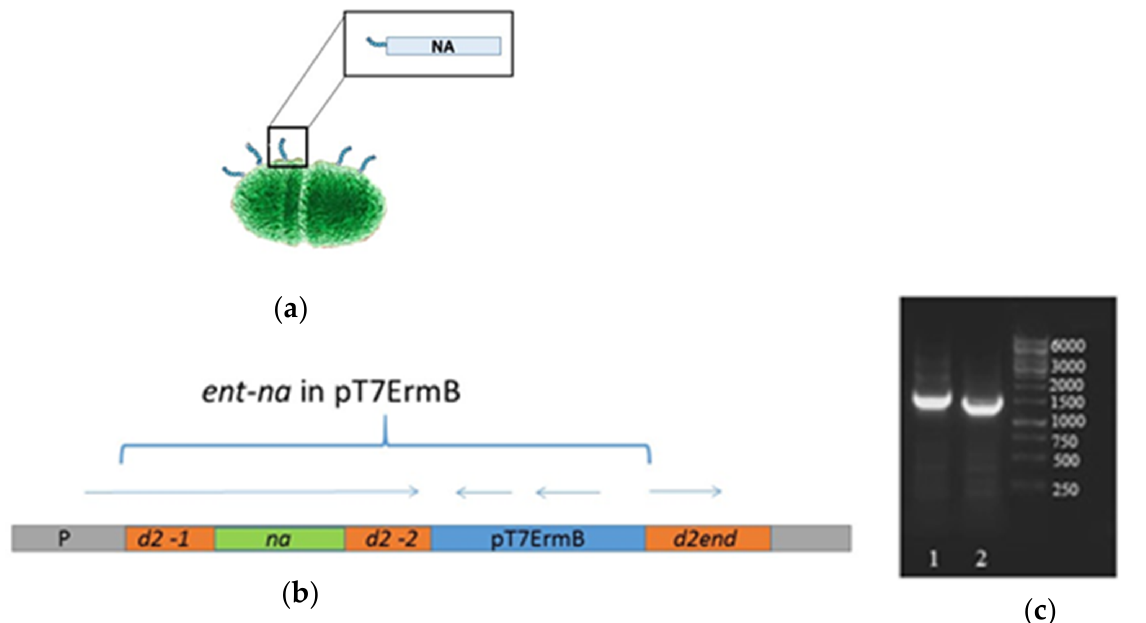
Figure 2. Generation of the live probiotic influenza vaccine candidate. ( a ) Schematic presentation of probiotic E. faecium vector; ( b ) Integration scheme of the plasmid pT7ermB with the ent-na into the chromosome of the strain E. faecium L3. P is the promoter of the gene d2; d2-1 is a region of the d2 gene encoding for the N-terminal part of D2 protein (209 amino acids—GenBank: HAQ0044242.1); d2-2 is a region of the d2 gene encoding for central and major part of C terminus portion of D2 protein (284–393 amino acids); na is DNA encoding neuraminidase; d2-end is the end of the d2 gene encoding for the C terminus of D2 protein (394–405 amino acids); pT7 ErmB is the integrative plasmid. Arrows correspond to the open reading frames in the integrated element. The entire integrated element ent-na with plasmid pT7ErmB is shown in brackets; ( c ) Agarose gel electrophoresis of the amplified bacterial gene d2 containing inserts of influenza virus gene fragments: 1, L3-NA; 2, L3.